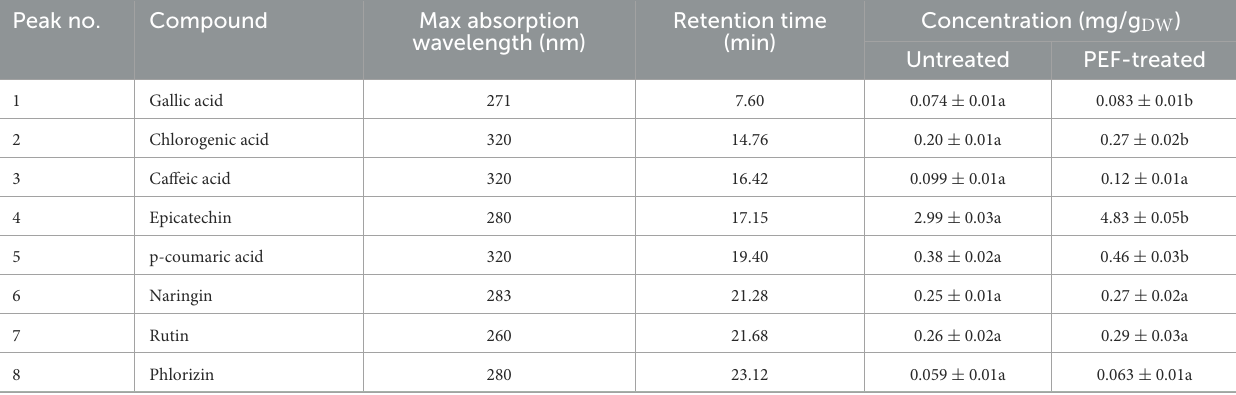
TABLE 7 Concentrations (mg/g DW ) of gallic acid, chlorogenic acid, caffeic acid, epicatechin, p-coumaric acid, naringin, rutin and phlorizin (HPLC/PDA analysis) in the extracts from untreated and PEF-treated grape pomace. Peak no. Compound Max absorption Retention time wavelength (nm)